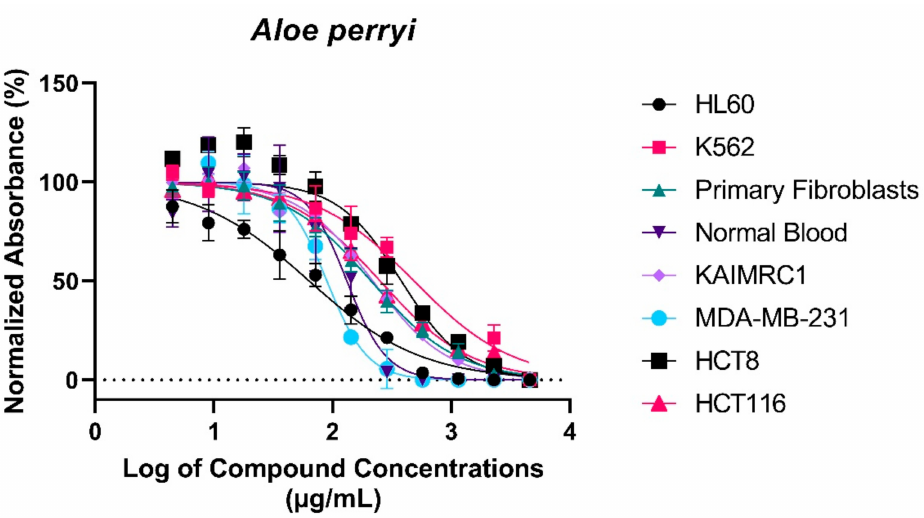
Figure 3. Graphical Representation of dose–response curve of Aloe perryi extract. Table 2. Aloe perryi IC 50 values. Breast cancer, colorectal cancer, and leukemia cell lines, primary fibroblasts, and normal blood cells were treated with graded concentrations of Aloe perryi , and IC 50 s were calculated. The Aloe perryi extract was dissolved in DMSO. R2 is the coefficient of differentiation and Se is the Standard